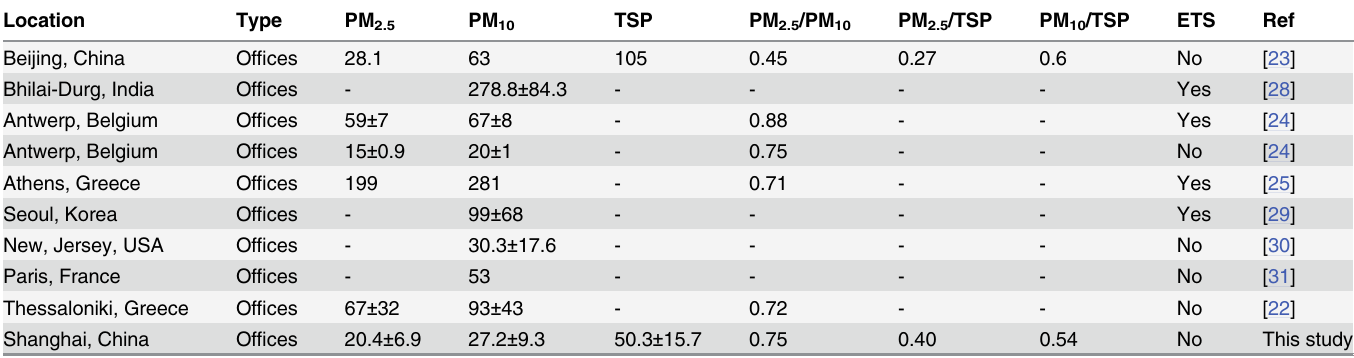
Table 1. Average concentrations of PM 2.5 , PM 10 and TSP in the present study and those from previous studies ( μ g/m 3 ).